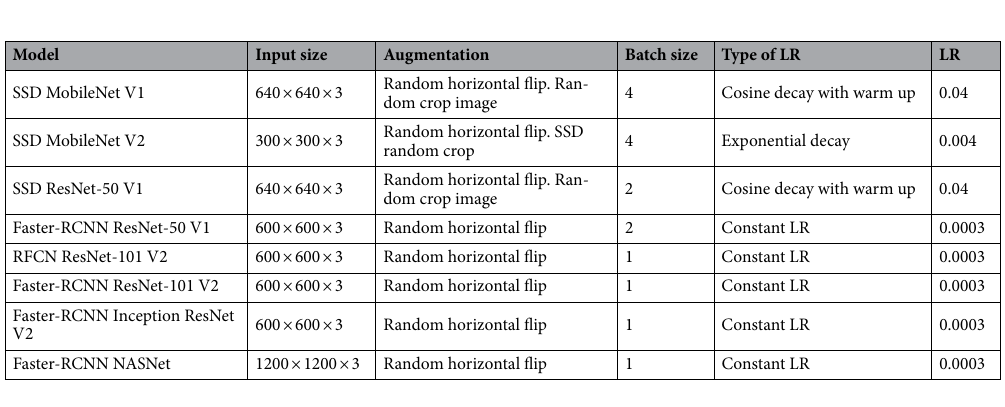
Table 3. Model training